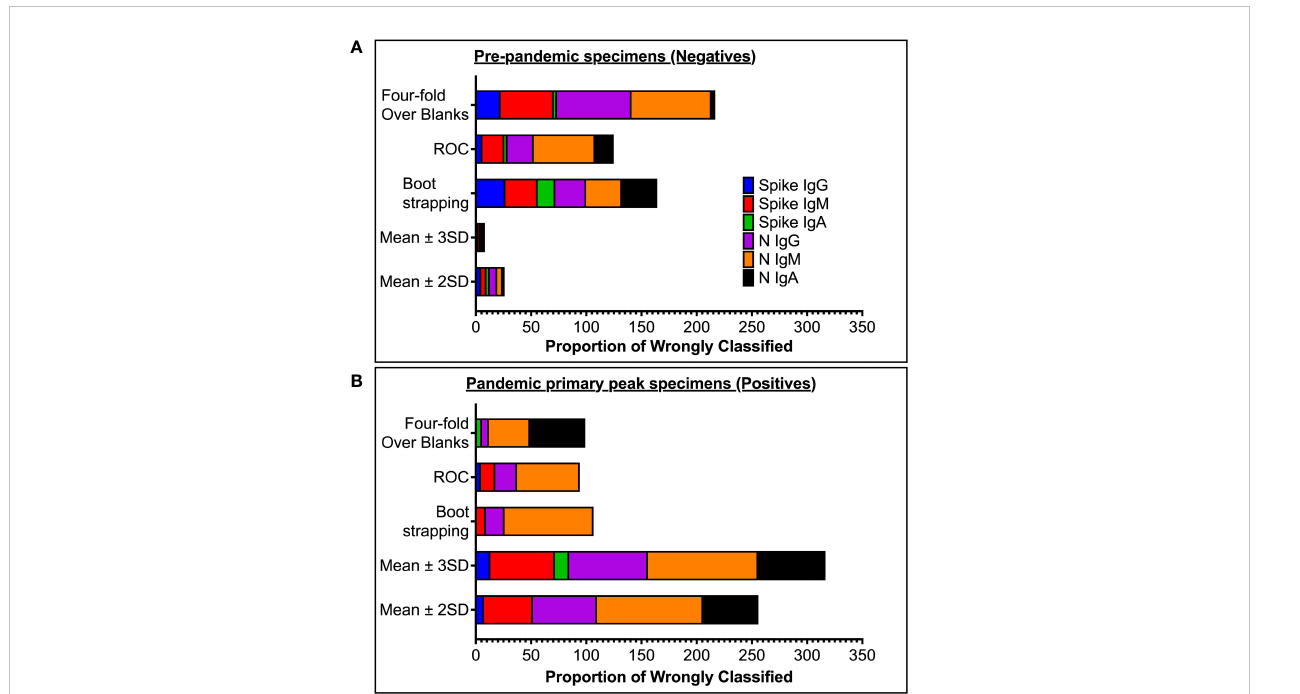
FIGURE 3 Proportion of wrongly classi fi ed specimen serostatus. (A) shows proportions of pre-pandemic (negative) specimens wrongly classi fi ed as positive (false positives). (B) shows proportions of antibody-peak specimens from PCR-con fi rmed subjects (positives) wrongly grouped as negative (false negative) using the fi ve different methods of computing cut-off